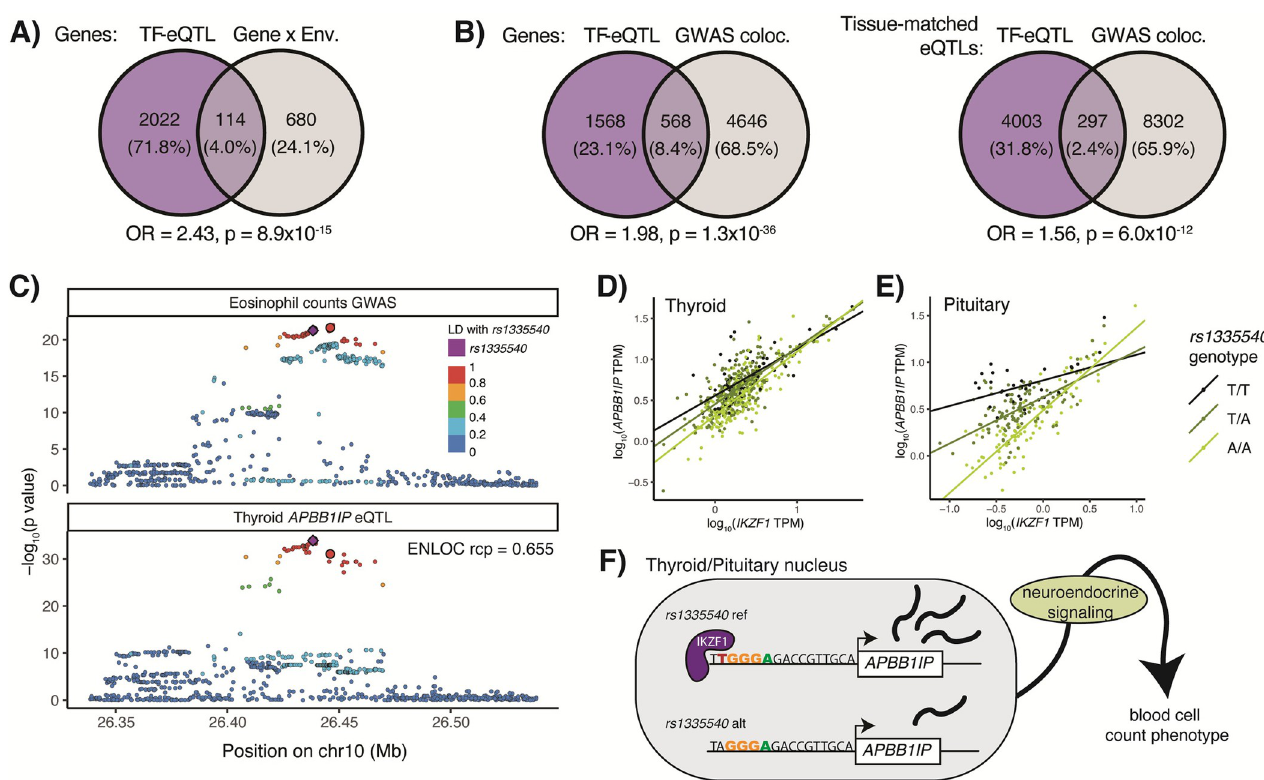
Fig 5. TF-eQTL implications for gene-by-environment and GWAS effects. A) Overlap of TF-eQTL genes with GxE genes from Findley et al. 2021. B) Overlap of TF-eQTL genes with GWAS colocalizing eQTL genes from GTEx. The first diagram shows overlap for a gene with a TF-eQTL in any tissue and colocalizing eQTL in any tissue. The second shows overlap of tissue eQTLs with TF-eQTL and/or colocalizing GWAS locus in the given tissue. C) Representative eQTL and GWAS p-values are plotted for variants in the region of an APBB1IP eQTL and blood trait GWAS locus. Lead variants from IKZF1-eQTL interactions in thyroid, pituitary, and tibial artery are larger and outlined in black. (The lead variant from pituitary/artery cannot be seen as it falls behind rs1335540.) D) & E) Individual samples in thyroid and pituitary tissues are plotted by IKZF1 and APBB1IP expression, and linear regression lines are plotted by genotype. The difference in APBB1IP expression between the genotypes gets smaller as IKZF1 expression increases across the samples. F) Schematic of IKZF1 regulation of APBB1IP and blood cell counts. An IKZF1 binding site predicted by the HOCOMOCO IKZF1 motif lies nine bases upstream of APBB1IP’s transcription start site, which is disrupted by the alternative allele of rs1335540. Under our neuroendocrine signaling hypothesis, APBB1IP expression in neuroendocrine tissues goes on to alter system-wide neuroendocrine signaling, which would cause changes in blood cell counts. As IKZF1 appears to regulate the APBB1IP eQTLs in these tissues, it would follow that IKZF1 TF therefore may regulate the effect of this locus on blood cell